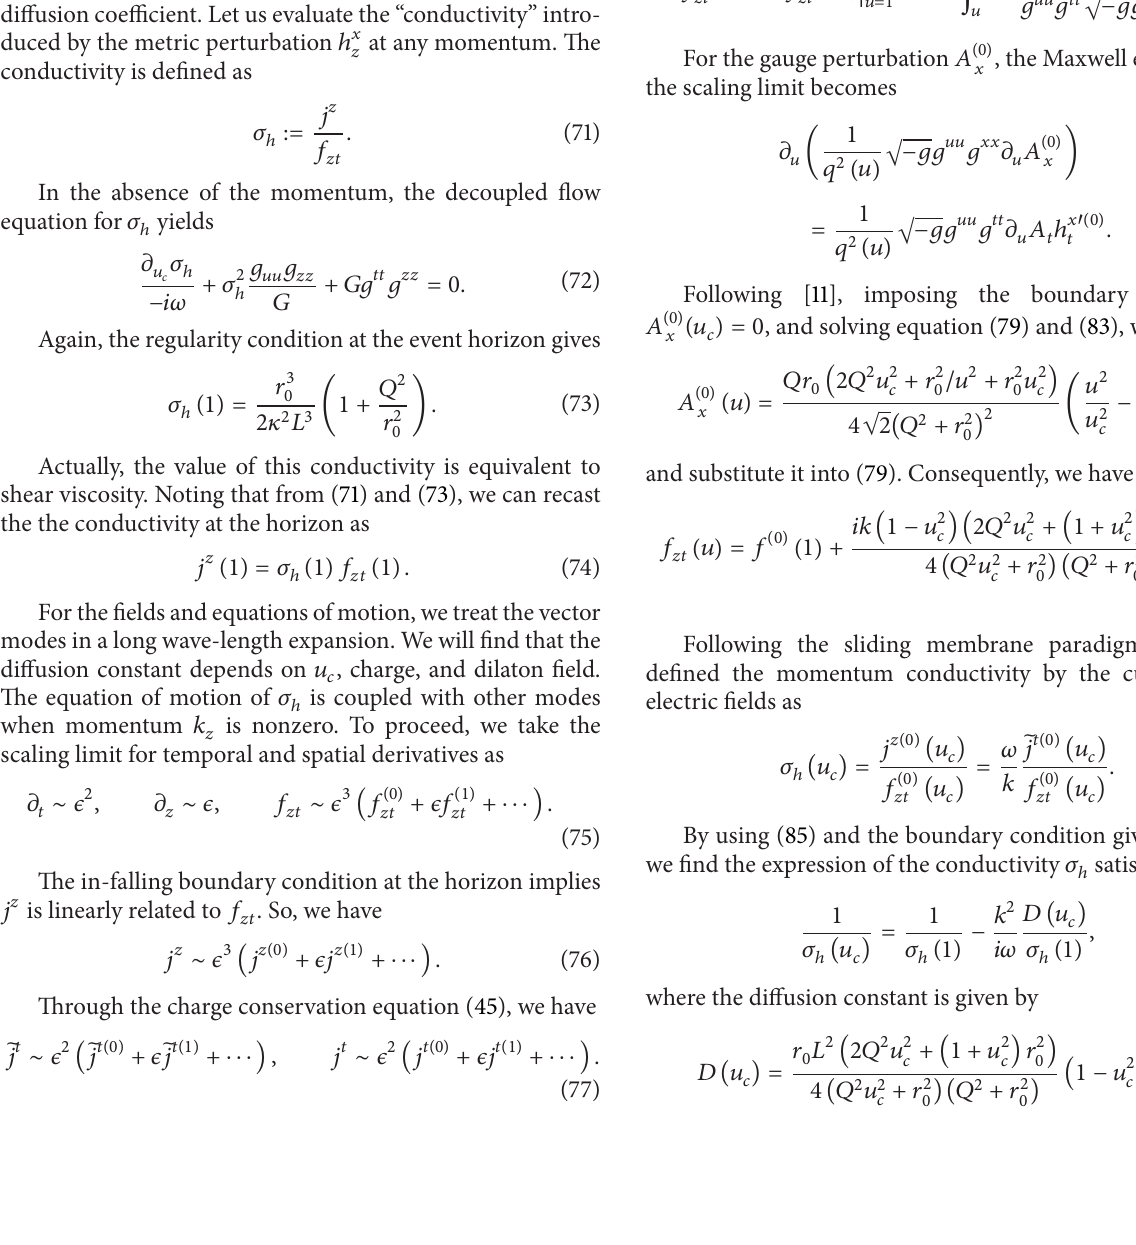
Figure 1: The DC conductivity as a function of the radial coordinate 𝑢 with different charges, where we set 𝐿 = 𝑟 dashed line corresponds to 𝑄 = 0